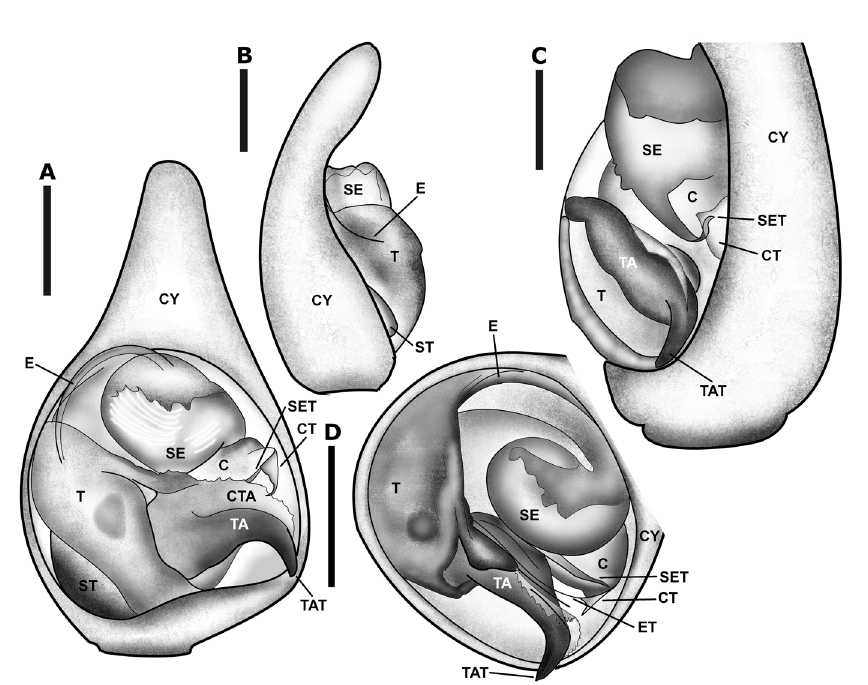
Fig. 13. Lycosa piochardi Simon, 1876, ♂ (HUJ INV-AR20948) right pedipalp (flipped) line drawings. A . Ventral view. B . Prolateral view. C . Retrolateral view. D . Distal view. Scale bars = 0.5 mm. Drawings by I. Armiach